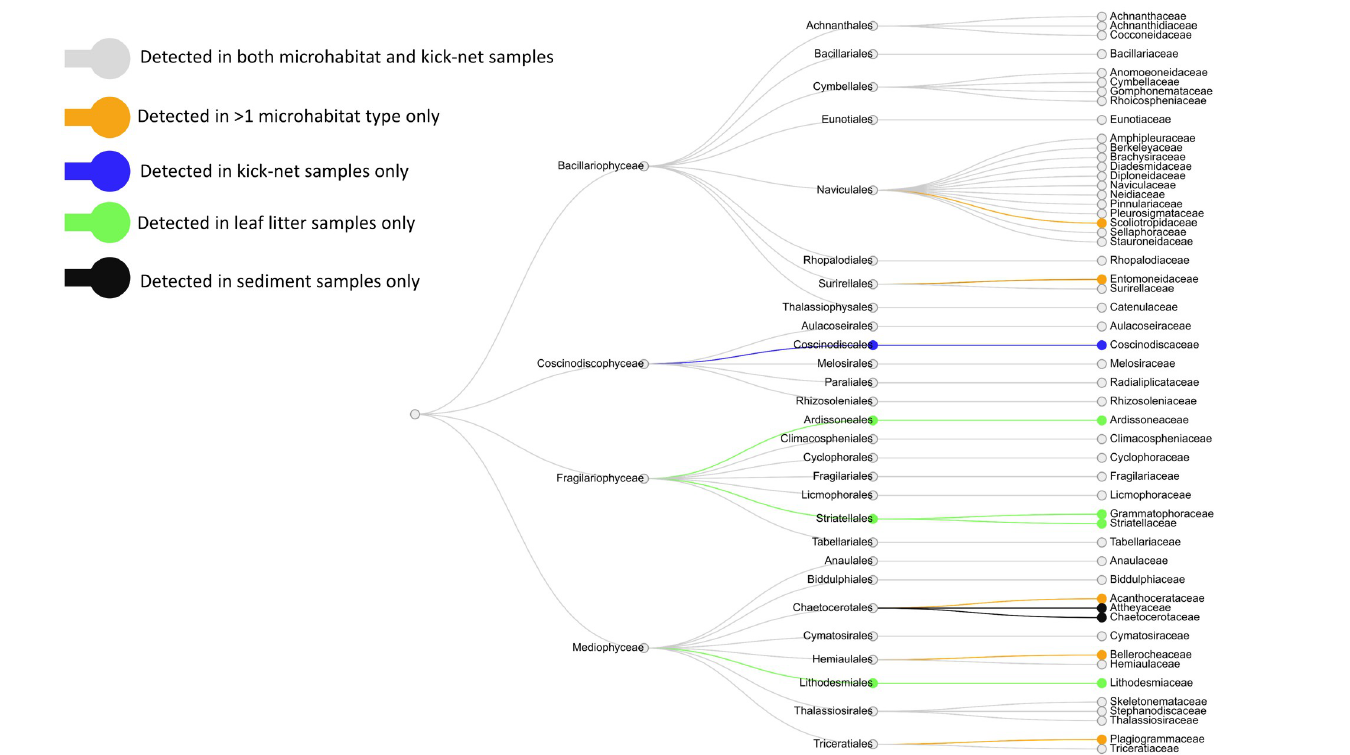
Fig 3. A majority of diatom families were detected in both microhabitat and kick-net samples. Left to right: Phylum (Bacillariophyta), Class, Order, Family.